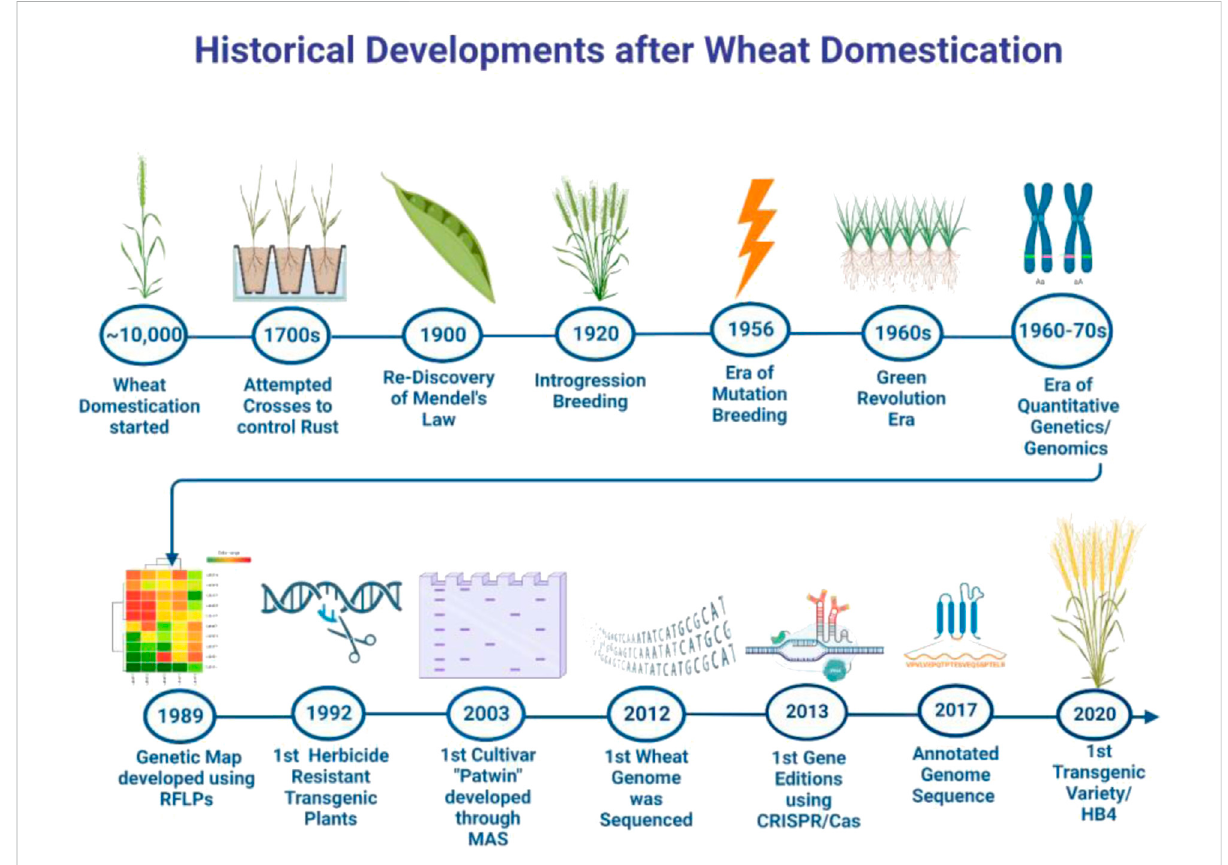
FIGURE 4 Timeline of historical developments in wheat research since its